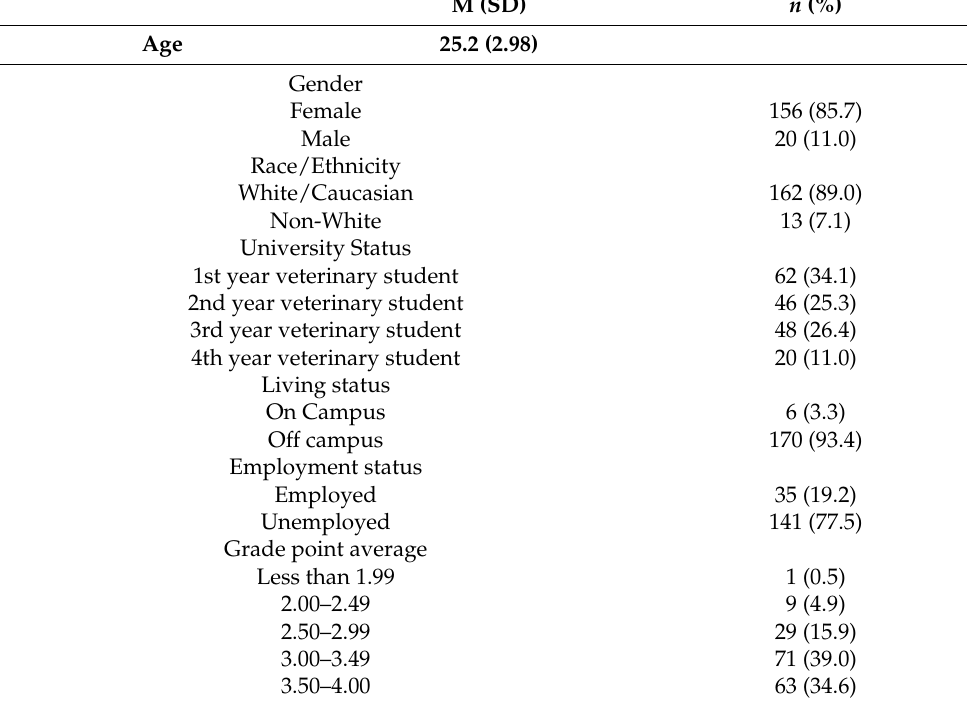
Table 1. Descriptive Statistics ( n =